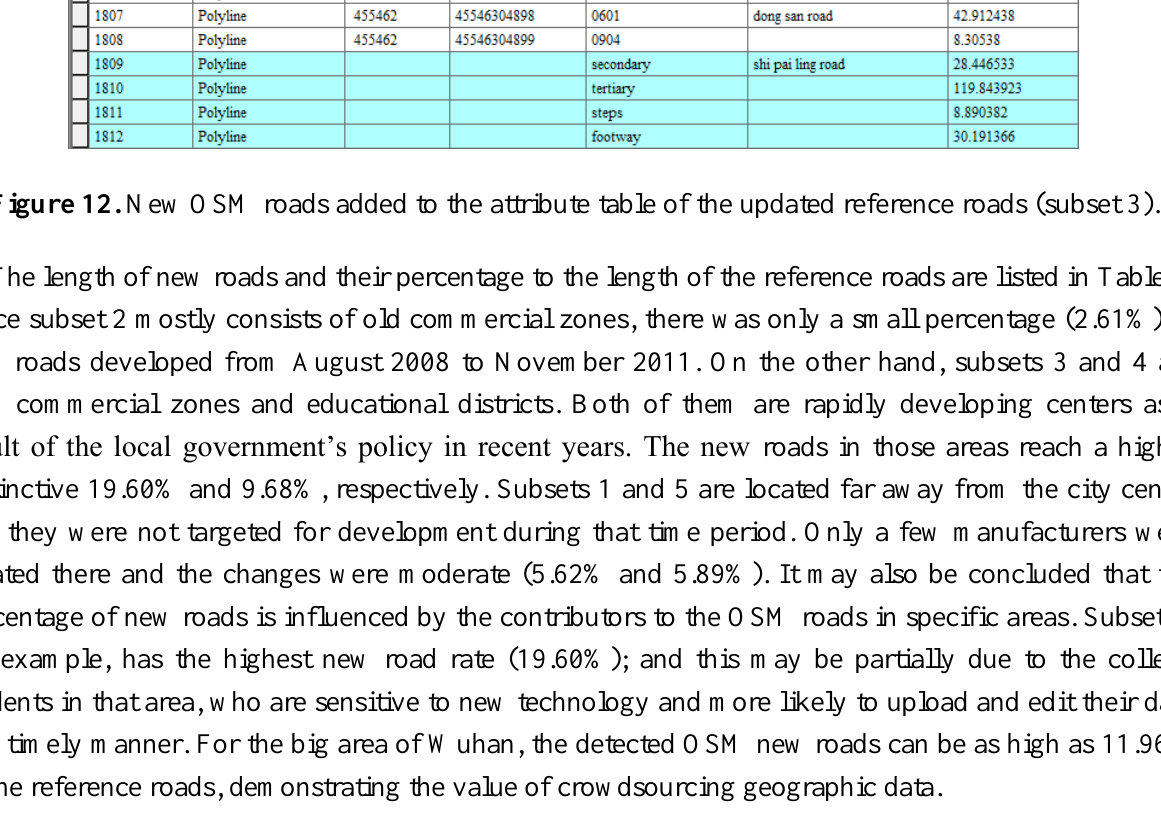
Table 4. Length and percentage of the detected new OSM